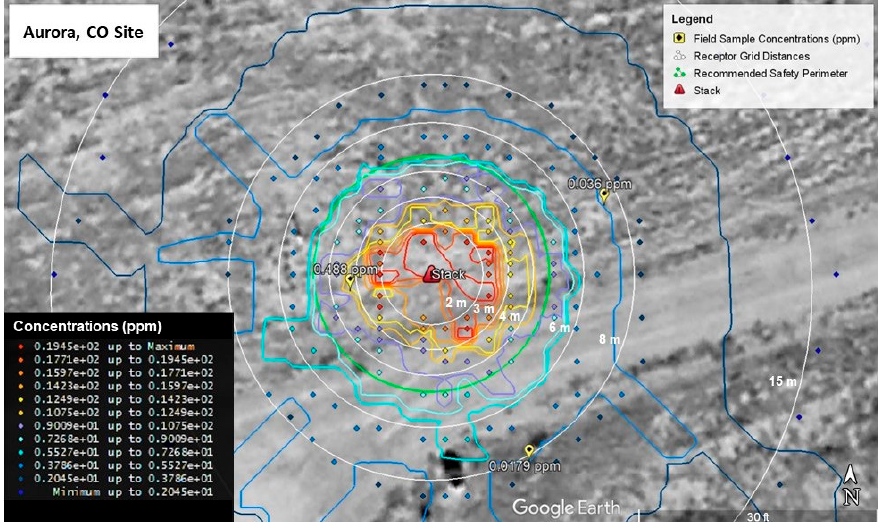
Figure 9. 5-year Modelled Styrene Emissions (Aurora Site).